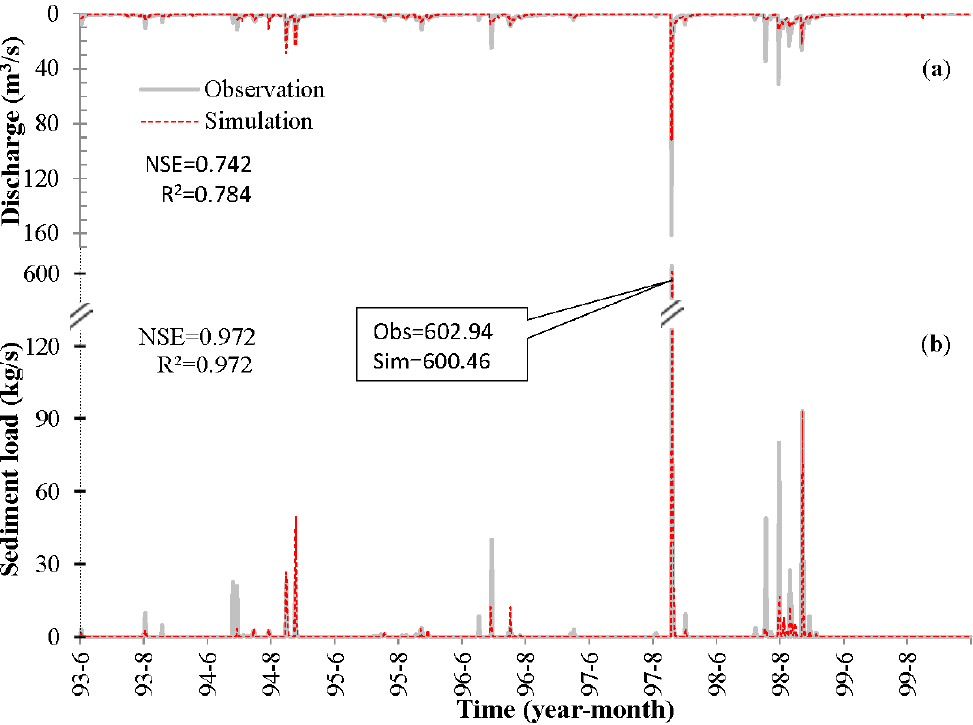
Figure 7. Optimal simulation results of BC-GED approach during the flood season (from June to September) in 1993–1999: ( a ) comparison of the observed and simulated river discharges; and ( b ) comparison of the observed (black solid line) and simulated (red dot line) sediment loads.